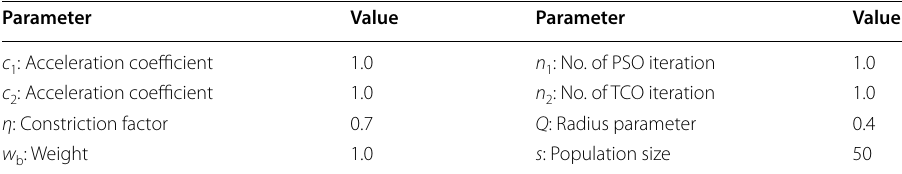
Table 1 Settings of the HPSTCO parameters